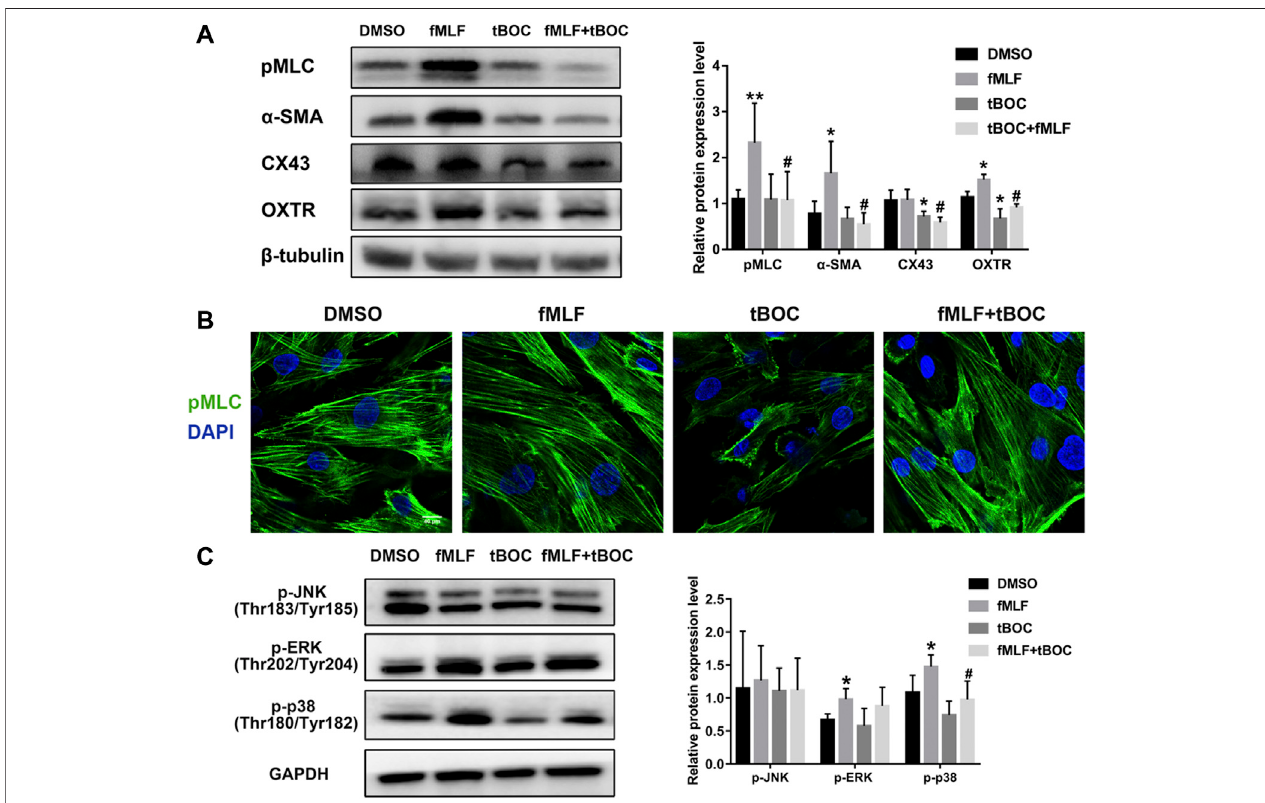
FIGURE 7 | FPR1 activation promoted expression of contractile proteins and MAPKs phosphorylation. (A) The protein expression of contractile proteinss in HutSMCs treated with DMSO (control), tBOC (5 μ M), fMLF (10 μ M), or fMLF/tBOC combination. (B) Distribution and expression of MLC phosphorylation in HutSMCs. ScaleBar (cid:1) 40 μ m. (C) TheeffectofFPR1onMAPKsphosphorylationinHutSMCstreatedwithDMSO(control),tBOC(5 μ M),fMLF(10 μ M),orfMLF/tBOCcombination for 24 h * p < 0.05 compared with control, # p < 0.05 compared with fMLF group.